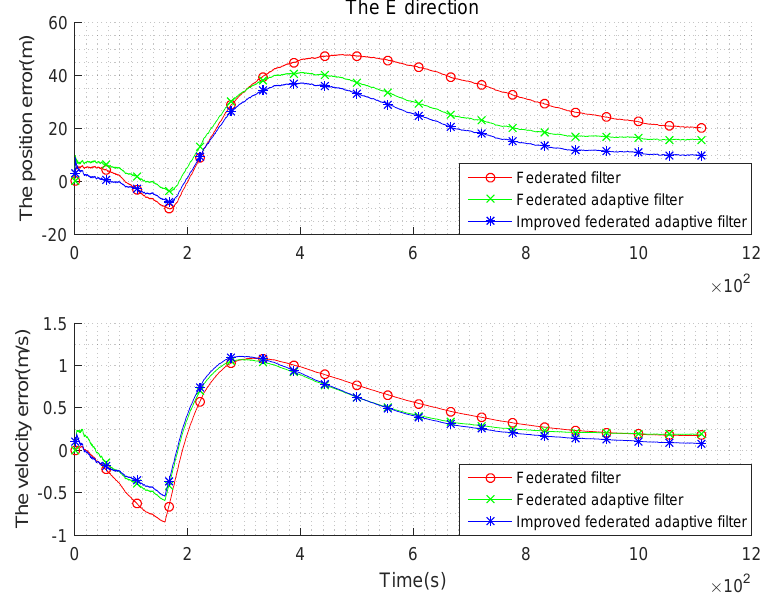
Figure 13. Comparison of the navigation error with time-varying state noise and biased estimation in E direction.